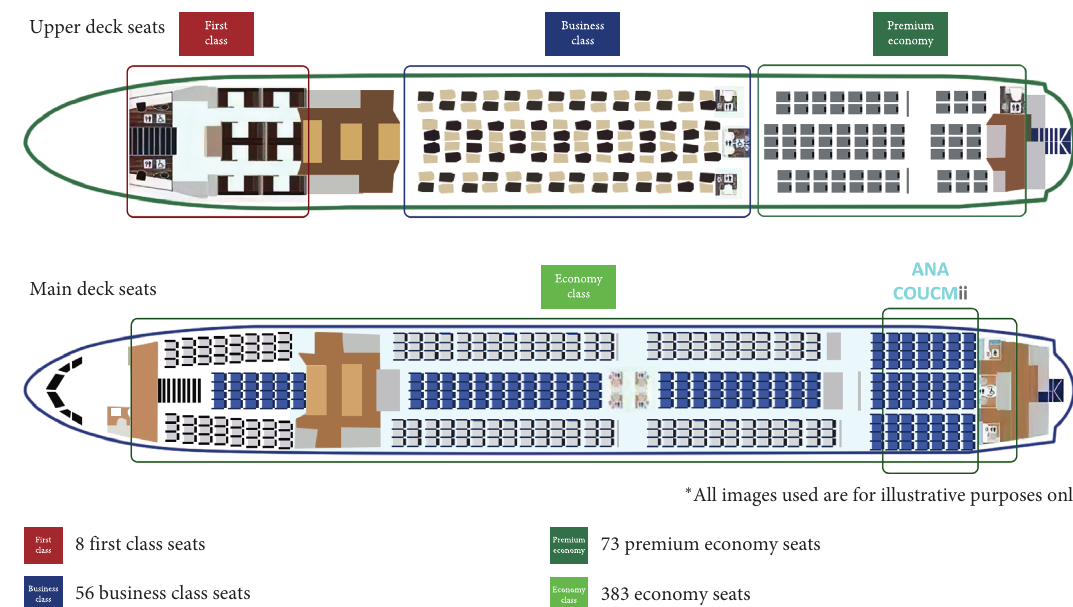
Figure 9: Seating configuration for an Airbus